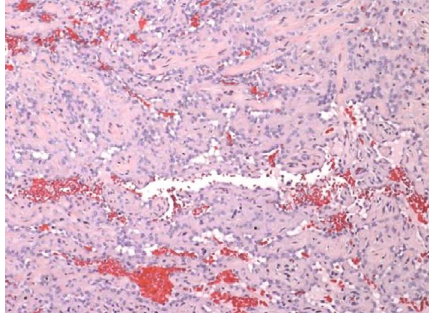
Figure 2: H&E staining of patient ’ s left facial angiosarcoma.